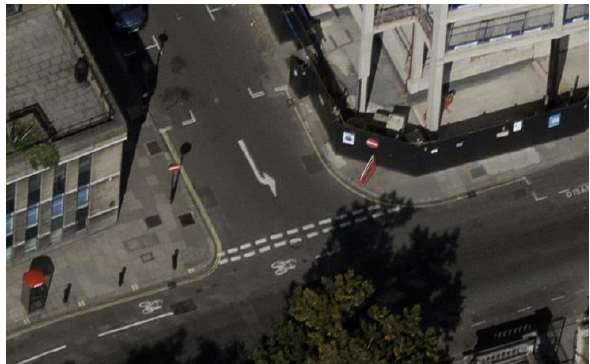
Figure 3a : Part of large-scale oblique BWD image (# 19103) of a flight mission (London, GSD 3,5 cm). The image has been processed with adaptive motion compensation (AMC).